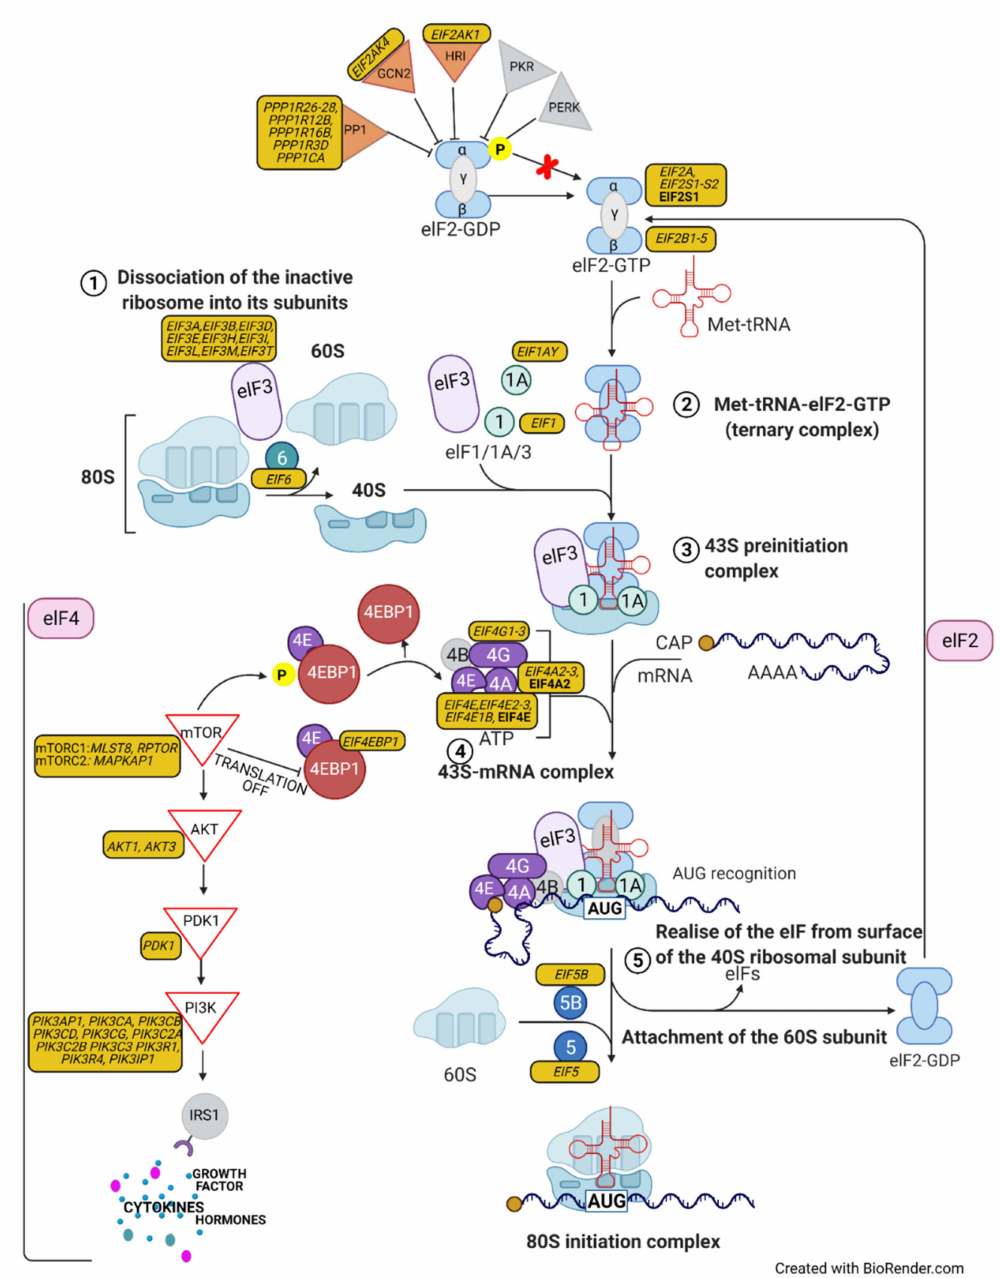
Figure 6. Transcripts/proteins identified in the inner perivitelline layer participating in protein synthesis by eIF2 signaling and eIF4 and p70S6K signaling. The scheme was prepared using the BioRender software. Description of gene/protein symbols are presented in the Supplementary Materials, Tables S1 and